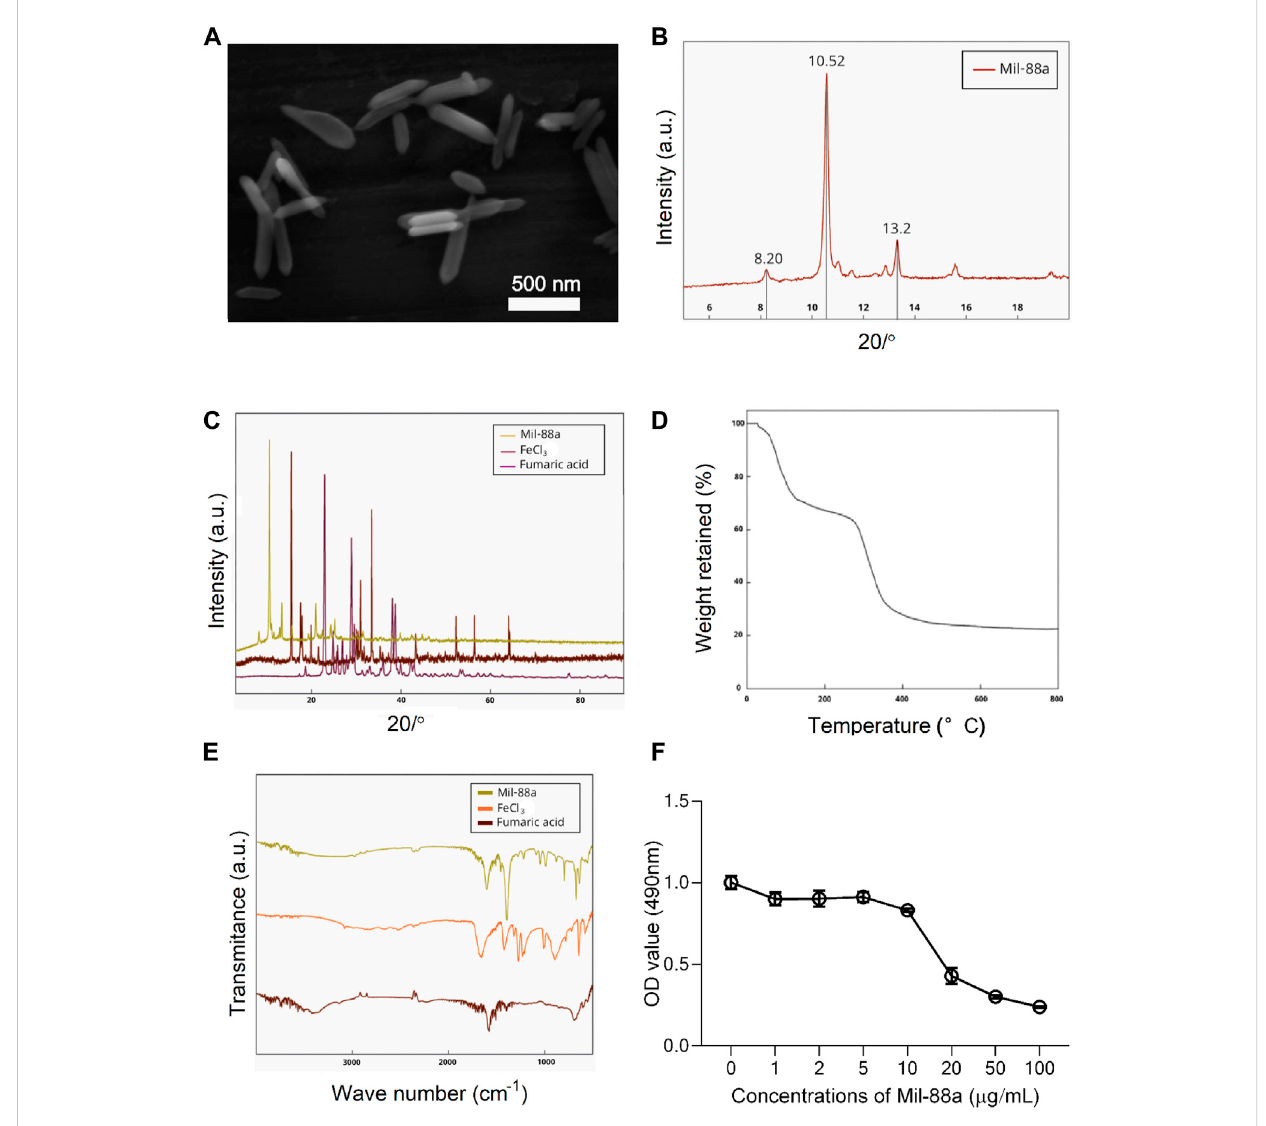
FIGURE 1 Characterization of Mil-88a. (A) Electron microscopy image of Mil-88a. (B) XRD characterization of Mil-88a. (C) XRD characterization of Mil-88a,